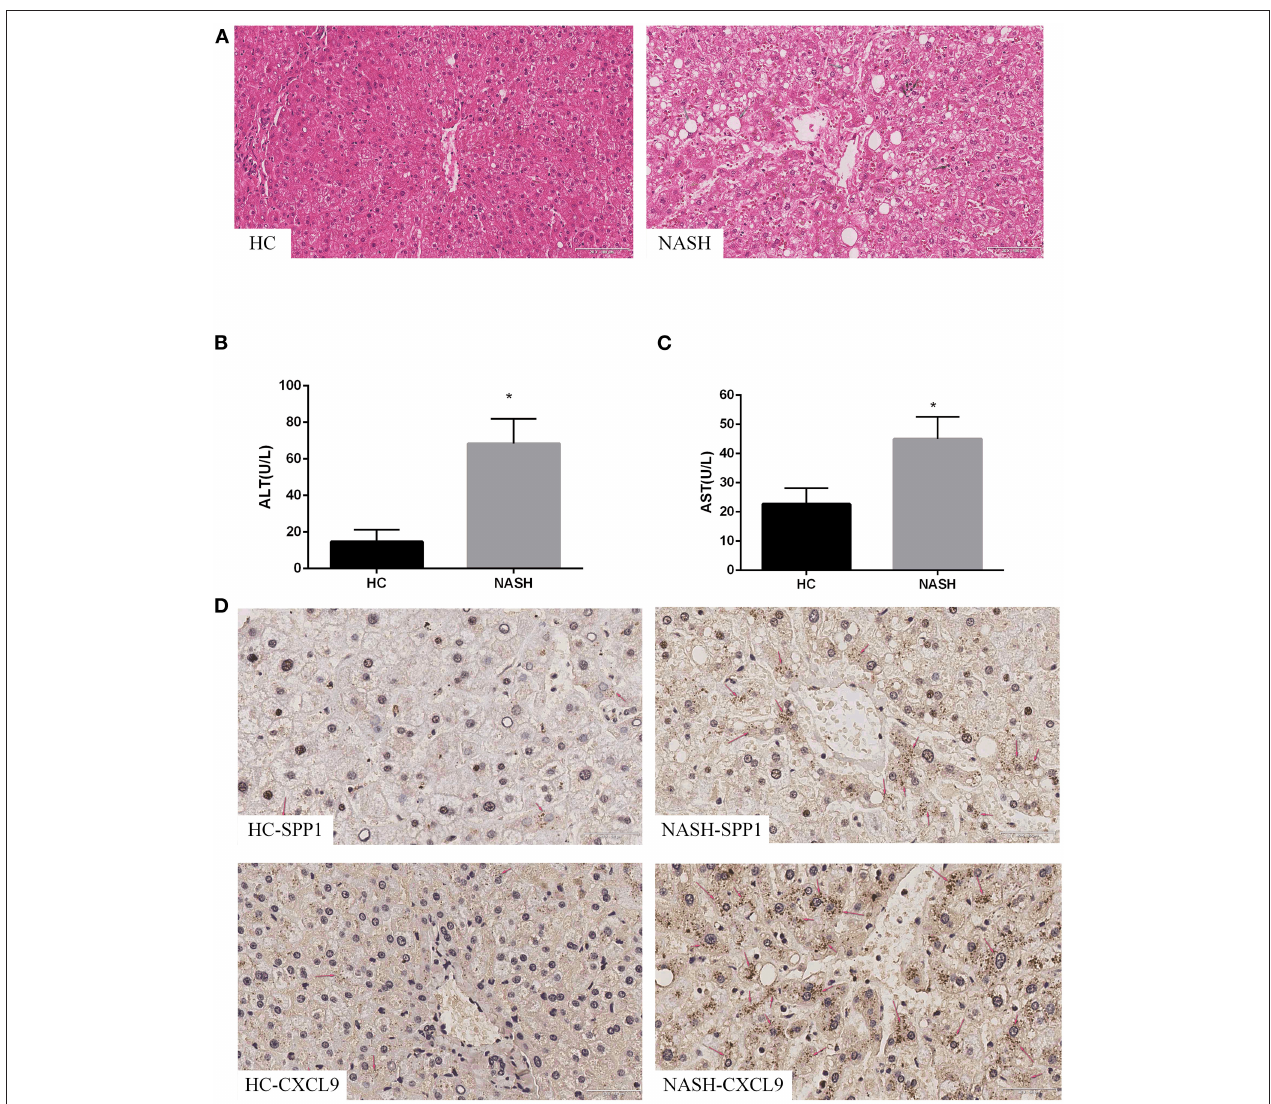
FIGURE 3 | Expression of SPP1 and CXCL9 in NASH patients. Serum biochemical indices change, morphological analysis and immunohistochemistry images of the expression of SPP1 and CXCL9 in NASH and HC group of human liver samples. (A) The liver samples were stained with hematoxylin–eosin (20 × ) in NASH and HC groups. The gray arrows represent steatosis, the red arrows represent hepatocyte ballooning degeneration, and the black arrows represent lobular infiltration. (B,C) Serum content of ALT and AST changes between HC patients and NASH patients. ALT and AST concentrations were significantly higher in NASH group than those in HC group. n = 5, * P < 0.05 compared with HC group. (D) Determination of the expression levels of SPP1 and CXCL9 in NASH and HC group of human liver samples using immunohistochemical staining (40 × ). The red arrows represent SPP1 or CXCL9 proteins in liver